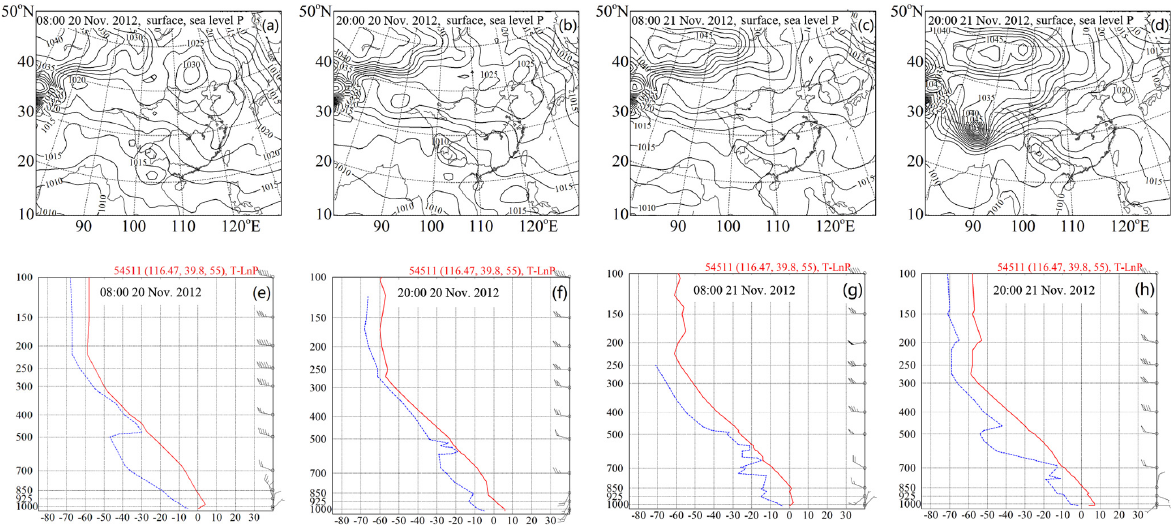
Figure 2. (a–d) Sea-level pressure field; (e–h) temperature–logarithmic pressure diagrams (blue dotted curves indicate dew point–pressure; red solid curves indicate stratification) at the Nanjiao station from 08:00LT 20 November 2012 to 20:00LT 21 November 2012.